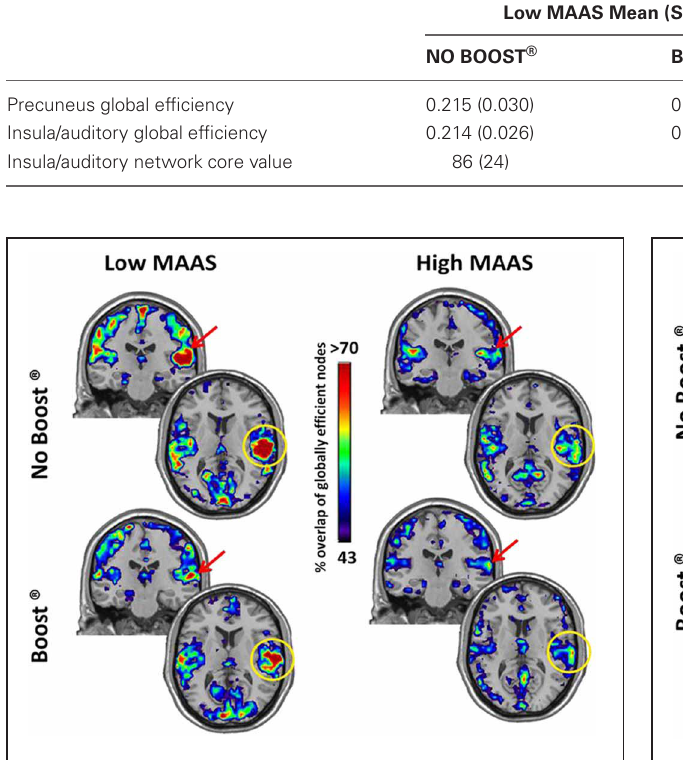
FIGURE 4 | K-core Maps by MAAS Category: Insula/Auditory Cortex. The regions that were consistently within the core of the network are depicted in these coronal and axial brain slices. The color-code indicates the % of subjects that had each region within their network core. Note the similarity with the regions that exhibited high global